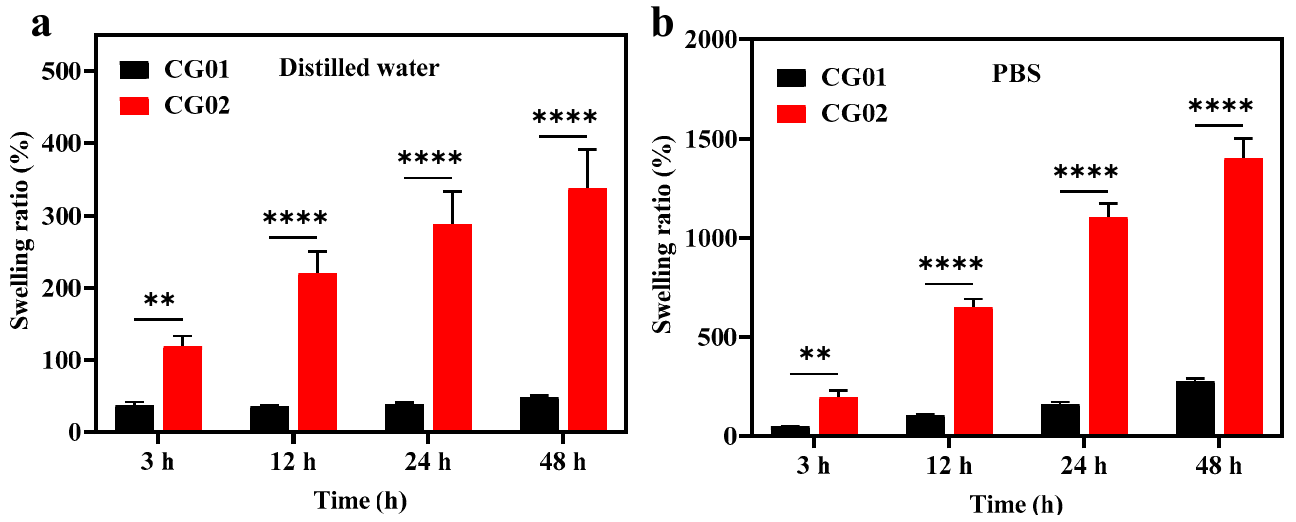
Figure 4. The swelling ratio of CG01 and CG02 samples after 3, 12, 24, and 48 h in ( a ) distilled water, and ( b ) PBS at 37 ◦ C. The results p < 0.01 (**) and p < 0.0001 (****) were considered as significant in compared to